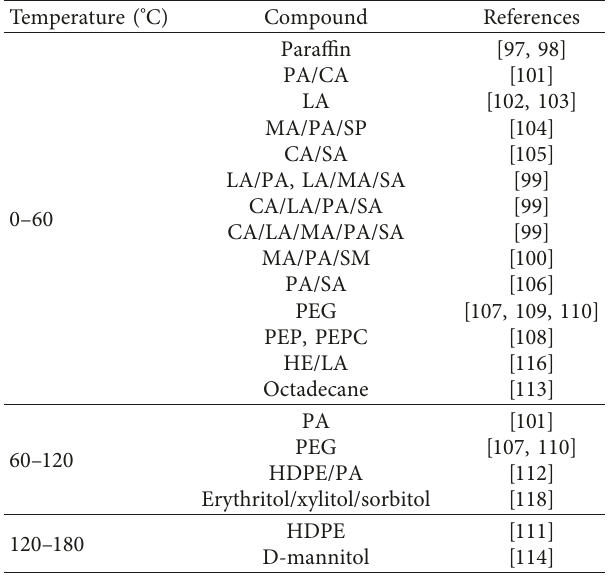
Table 7: The melting point of organic eutectic composites.